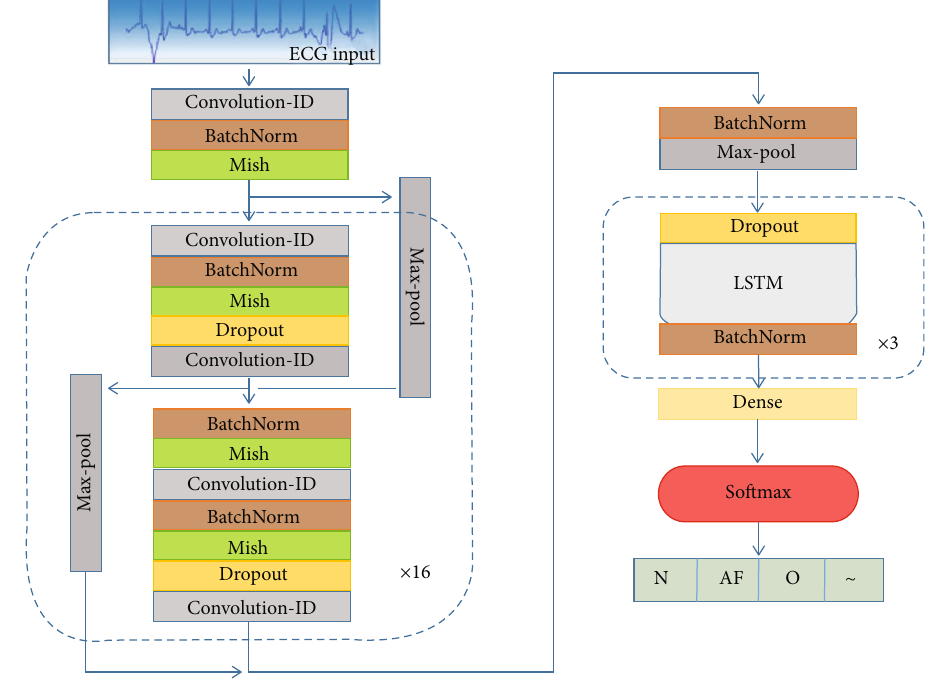
Figure 4: ResNet34-LSTM3 network structure diagram.